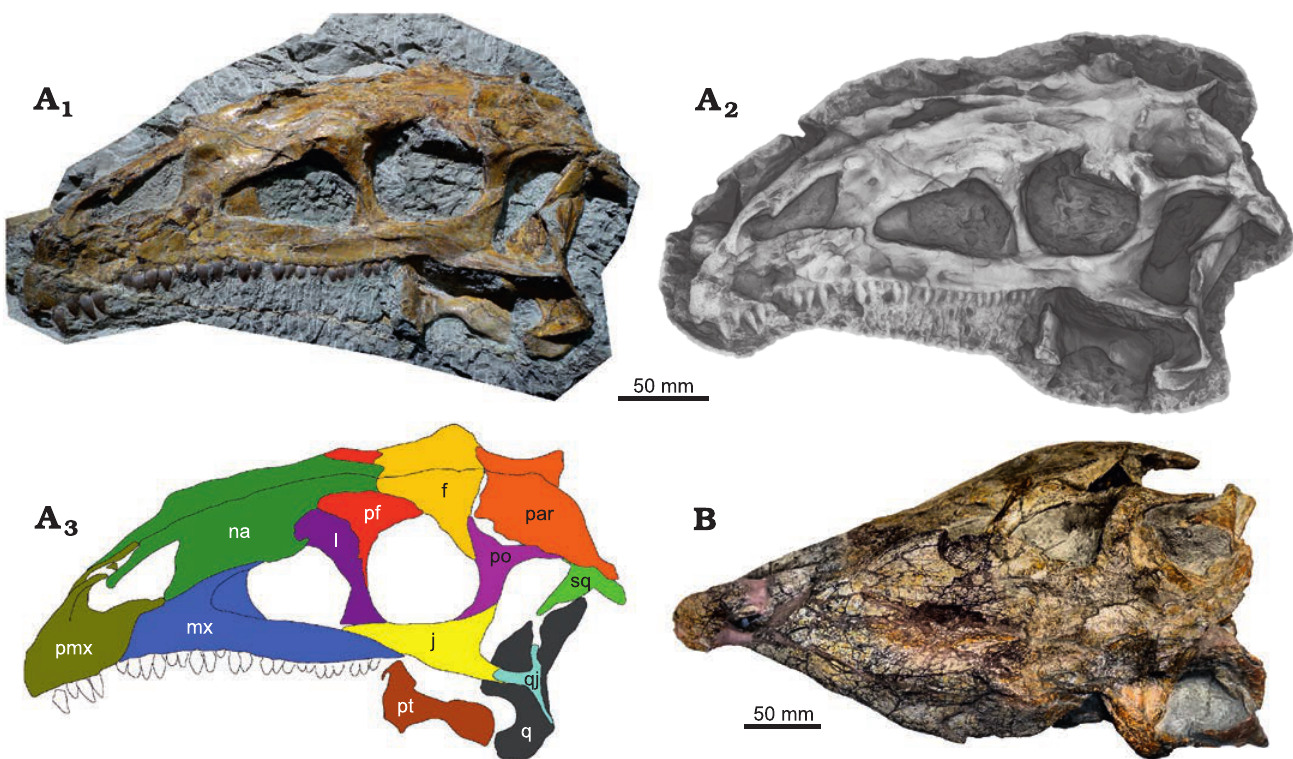
Fig. 5. A . Skull of Plateosaurus trossingensis (MSF 15.4) from the Triassic of Frick, Switzerland. Photograph in lateral view (A 1 ); a mbient occlusion of 3D-model (A 2 ); i nterpretative diagram (A 3 ). B . Photograph of SMNS 12949 in dorsal view. Abbreviations: f, frontal; j, jugal; l, lacrimal; mx, maxilla; na, nasal; par, paroccipital process; pf, prefrontal; pmx, premaxilla; po, postorbital; pt, pterygoid; q, quadrate; qj, quadratojugal; sq,